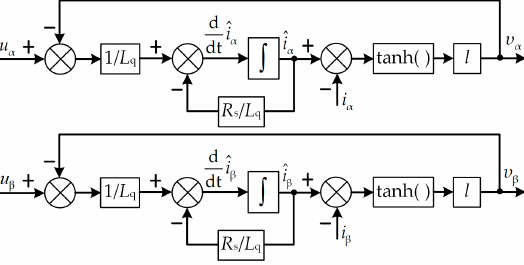
Figure 1. Structure block diagram of Sliding Mode Observer (SMO) based on extended flux (EF).